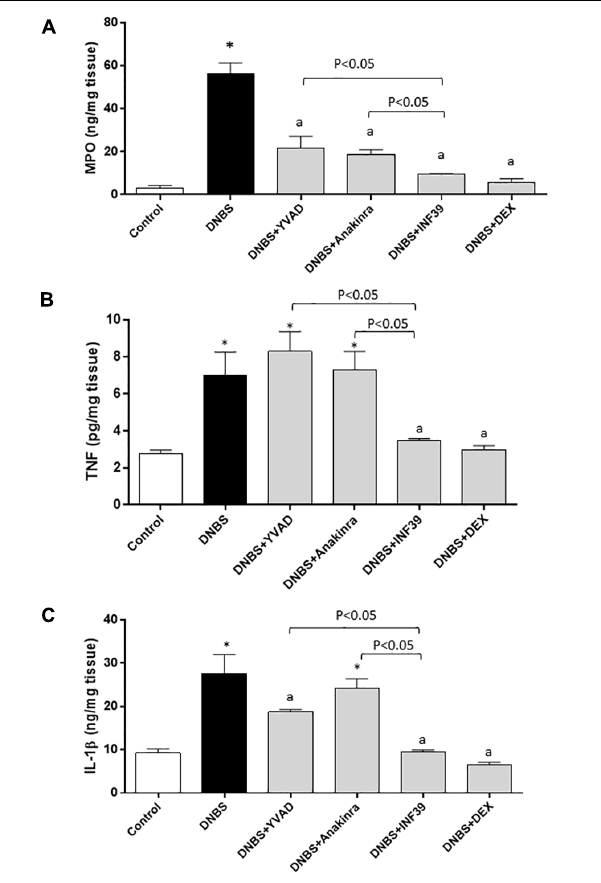
FIGURE 4 | Myeloperoxidase (MPO) (A) , tumor necrosis factor (TNF) (B) and interleukin-1 β (IL-1 β ) (C) levels in colonic tissues from control rats or animals with DNBS-induced colitis, either alone or after treatment with Ac-YVAD-cmk (YVAD, 3 mg/Kg), anakinra (100 mg/Kg), INF39 (25 mg/kg) or DEX (1 mg/kg). Each column represents the mean ± S.E.M. ( n = 10). ∗ P < 0.05, significant difference vs. control group; a P < 0.05, significant difference vs. DNBS